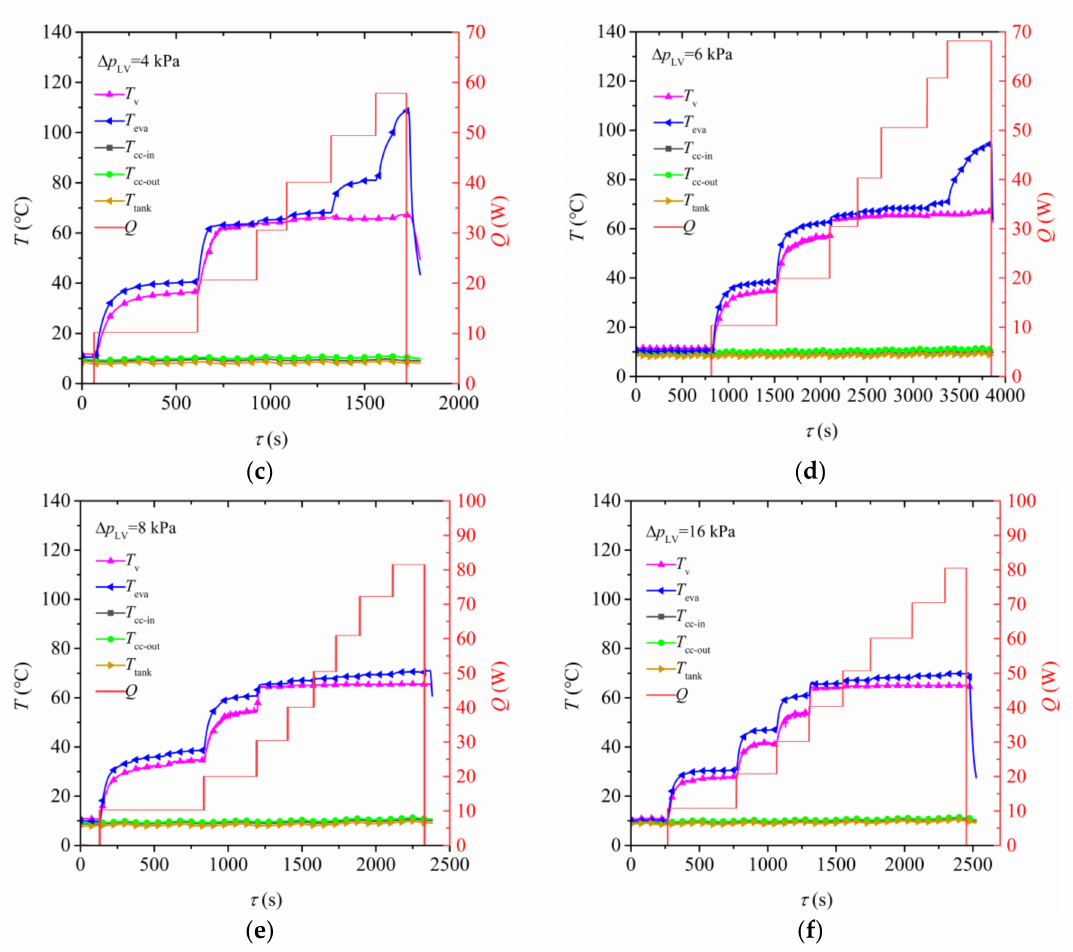
Figure 3. Start-up characteristics of the hybrid phase-change loop under different pressure differences: ( a ) ∆ p LV = 0 kPa; ( b ) ∆ p LV = 2 kPa; ( c ) ∆ p LV = 4 ka; ( d ) ∆ p LV = 6 kPa; ( e ) ∆ p LV = 8 kPa; ( f ) ∆ p LV = 16